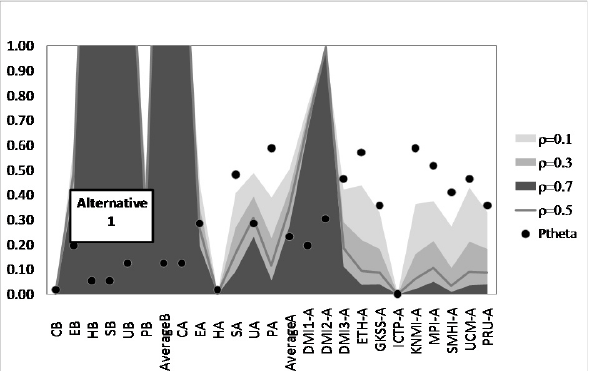
Fig. 7. Economic value of perfect information as a function of the risk aversion